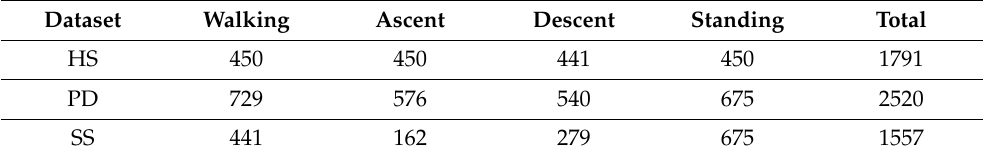
Table 2. Number of occurrences after data augmentation (enhanced state) in the local dataset.